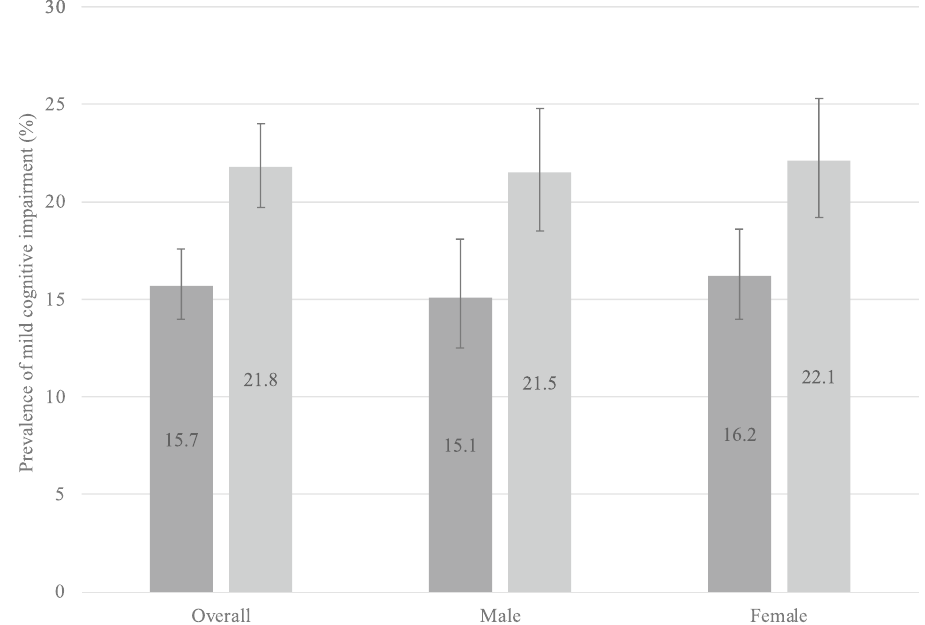
Figure 1. Prevalence of mild cognitive impairment by cooking fuel type (overall and by sex). Bars denote 95% confidence